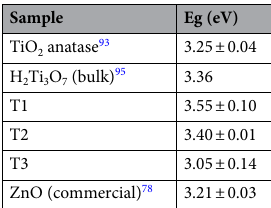
Table 2. Optical bandgap energy (Eg) of samples T1, T2 and T3 and related precursors.